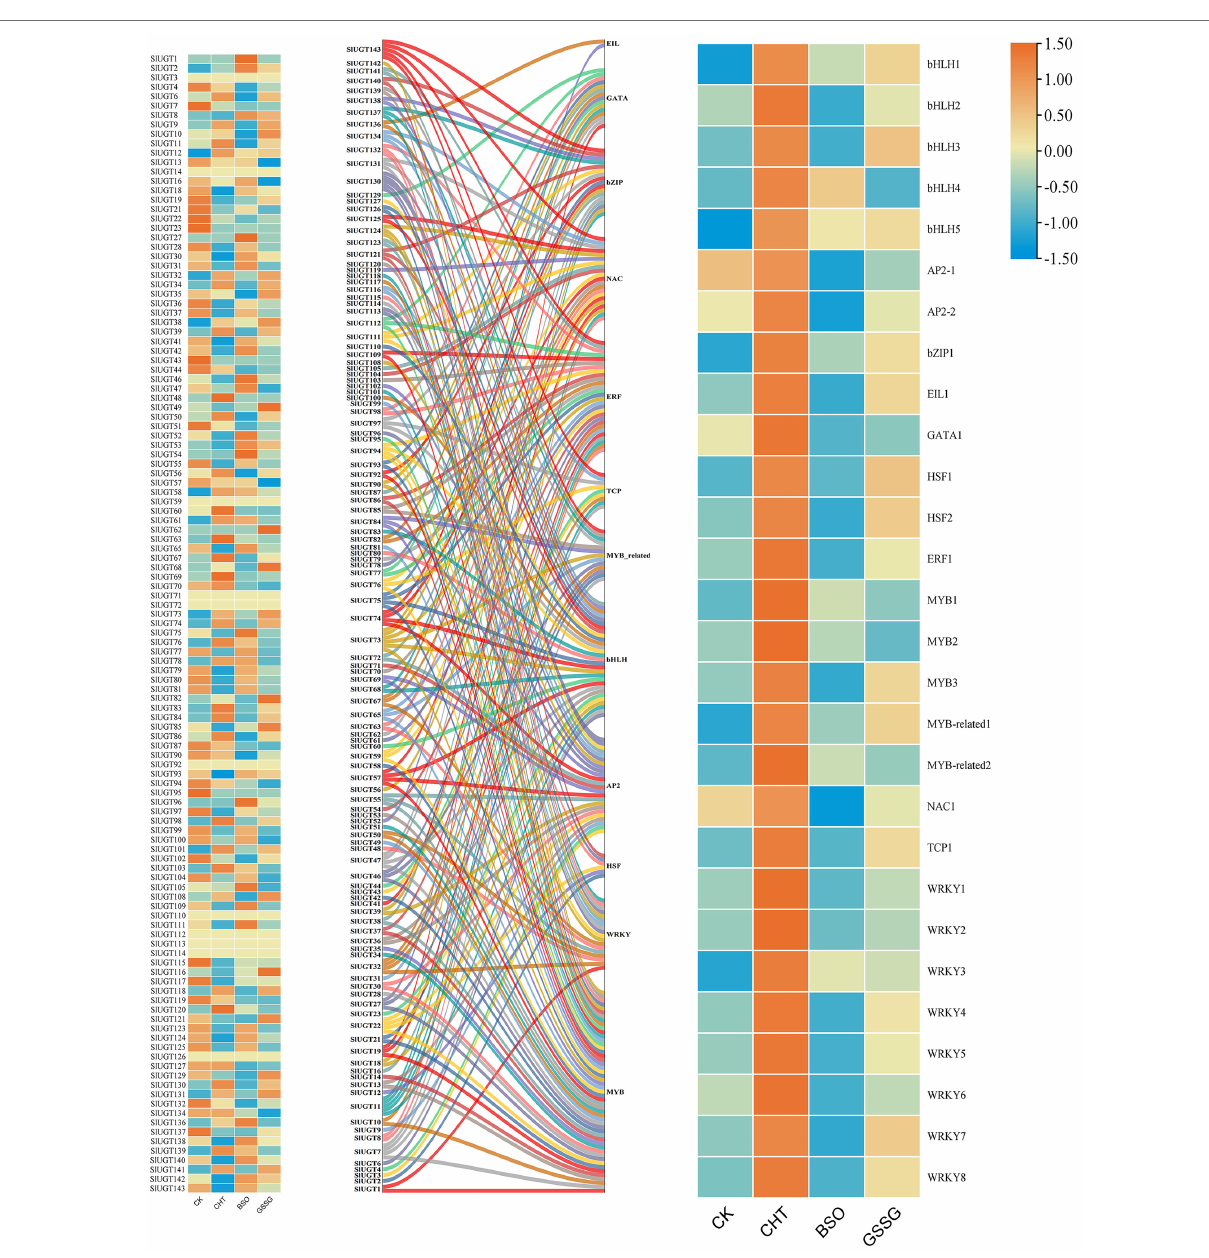
FIGURE 12 | Network analysis of tomato UGT genes and transcription factors and Expression profiles of different SlUGT genes and transcription factors in response to different treatments. Different colors represent different SlUGT